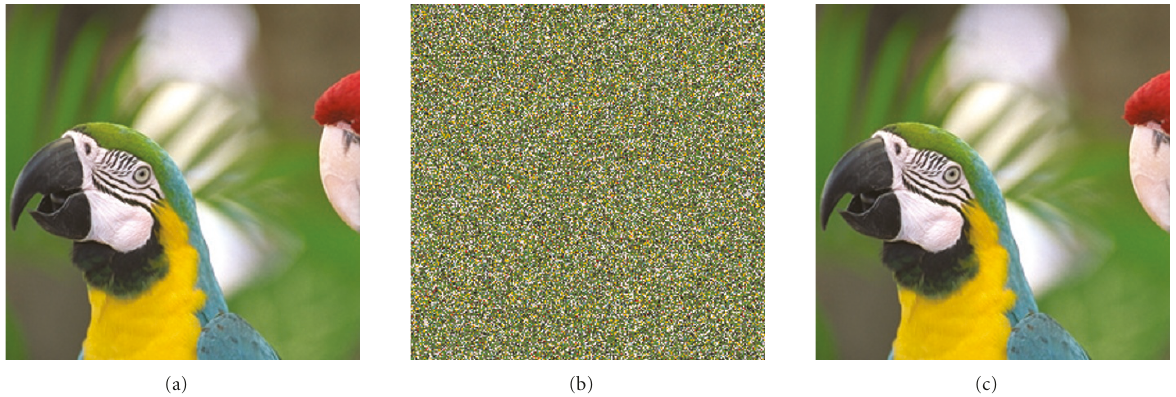
Figure 8: Visual impact of the proposed encryption-watermarking scheme for the image Parrot: (a) original image; (b) encrypted- watermarked image; (c) decrypted-watermarked image.